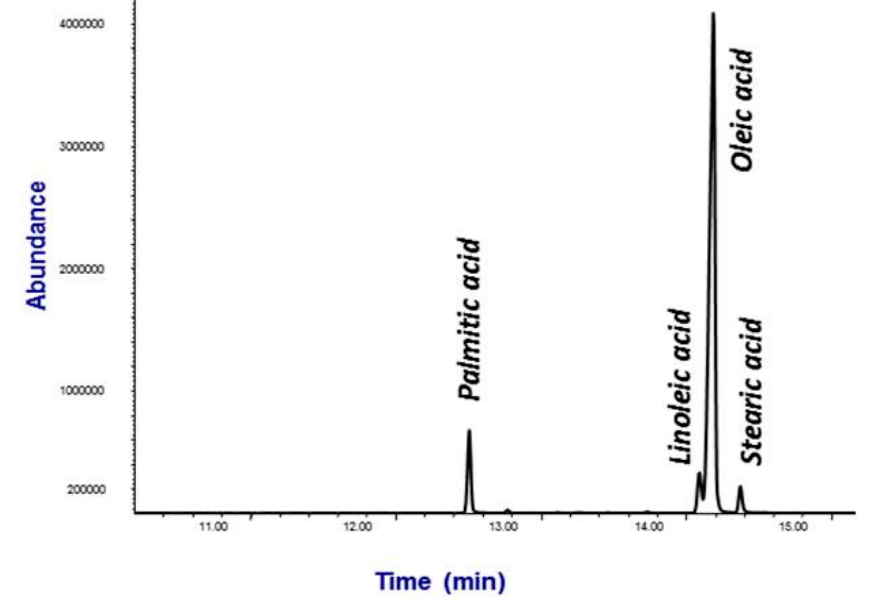
Figure 4. Total ion chromatogram (TIC) showing the main fatty acids of Camellia japonica seeds. Table 5. Fatty acids content (%) in seeds from Camellia grown in Galicia (SUA, sum of unsaturated fatty acids, SSA, sum of saturated fatty